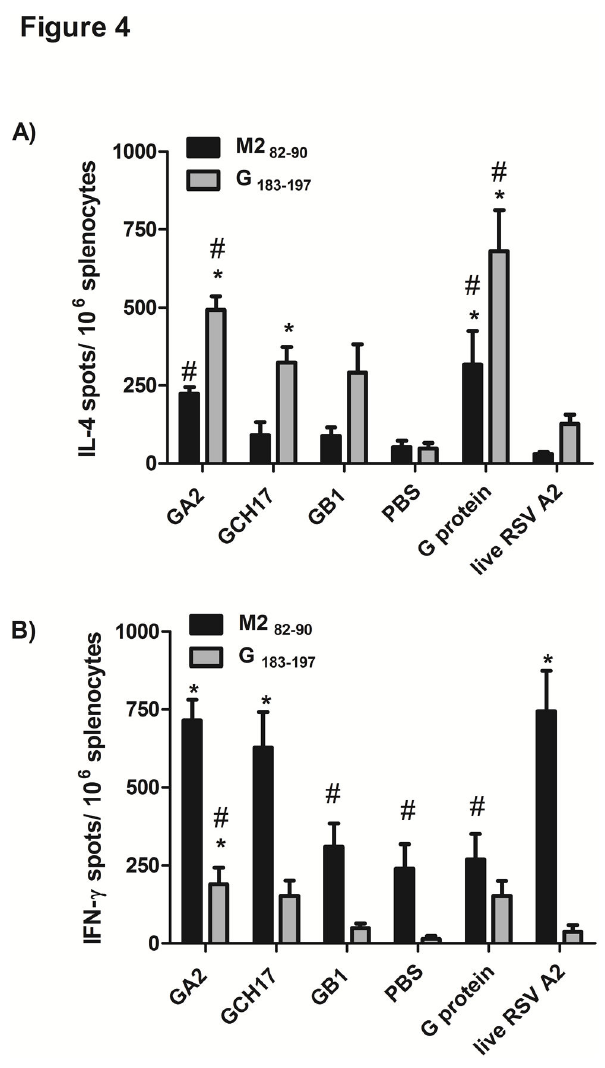
protected against RSV